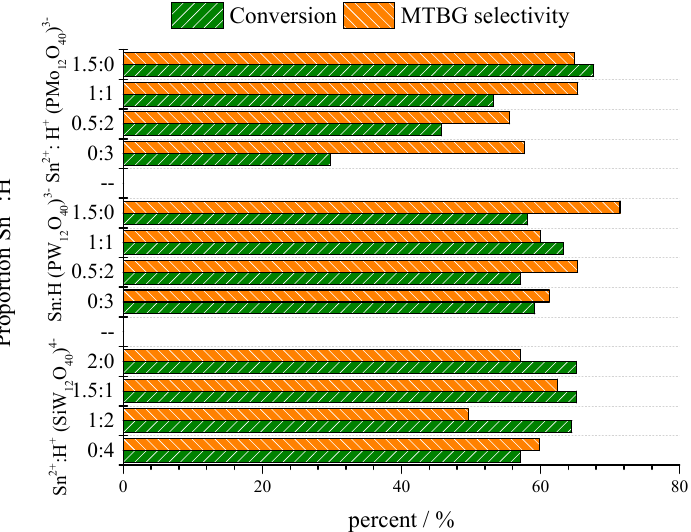
Figure 23. Impact of variation in the Sn 2+ : H + proportion on the conversion and selectivity of glycerol etherification reactions with tert − butyl alcohol (adapted from ref. [65].